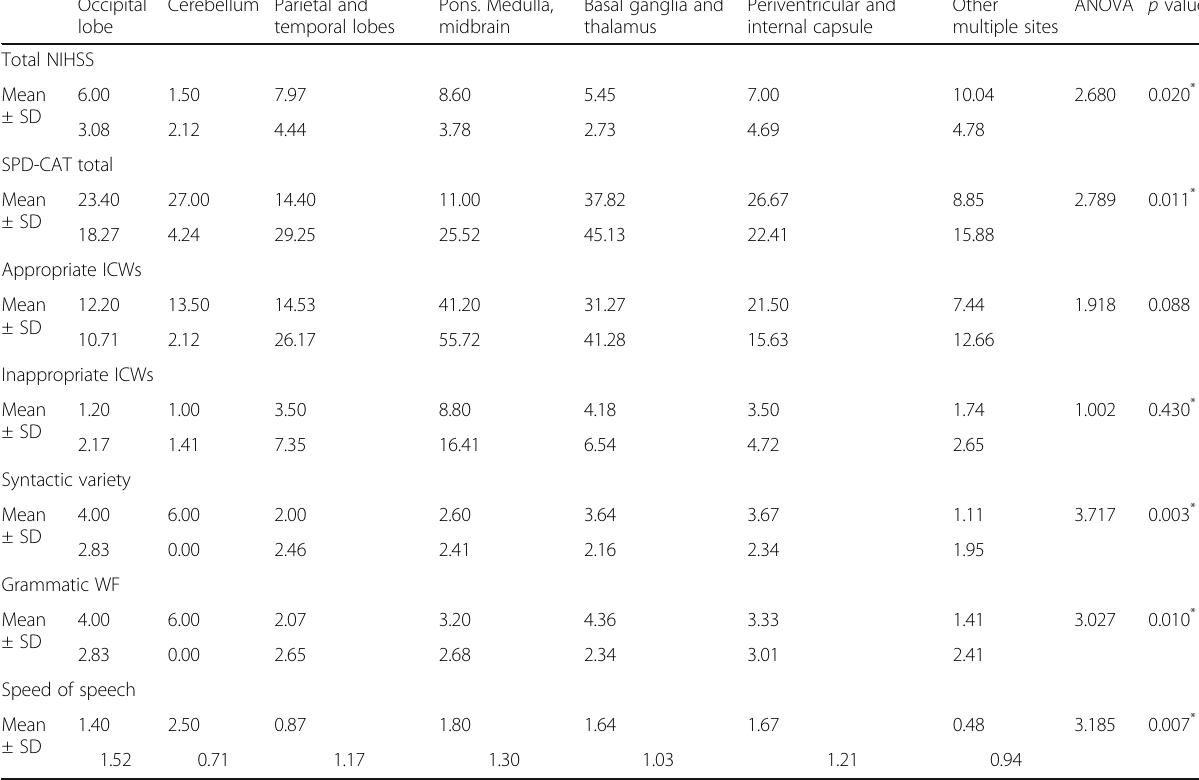
Table 12 Relation between total NIHSS, total SPD-CAT, content units of SPD-CAT (subscale scores), and lobar site of stroke Occipital Cerebellum Parietal and Pons. Medulla, Basal ganglia and Periventricular and lobe temporal lobes midbrain thalamus internal capsule